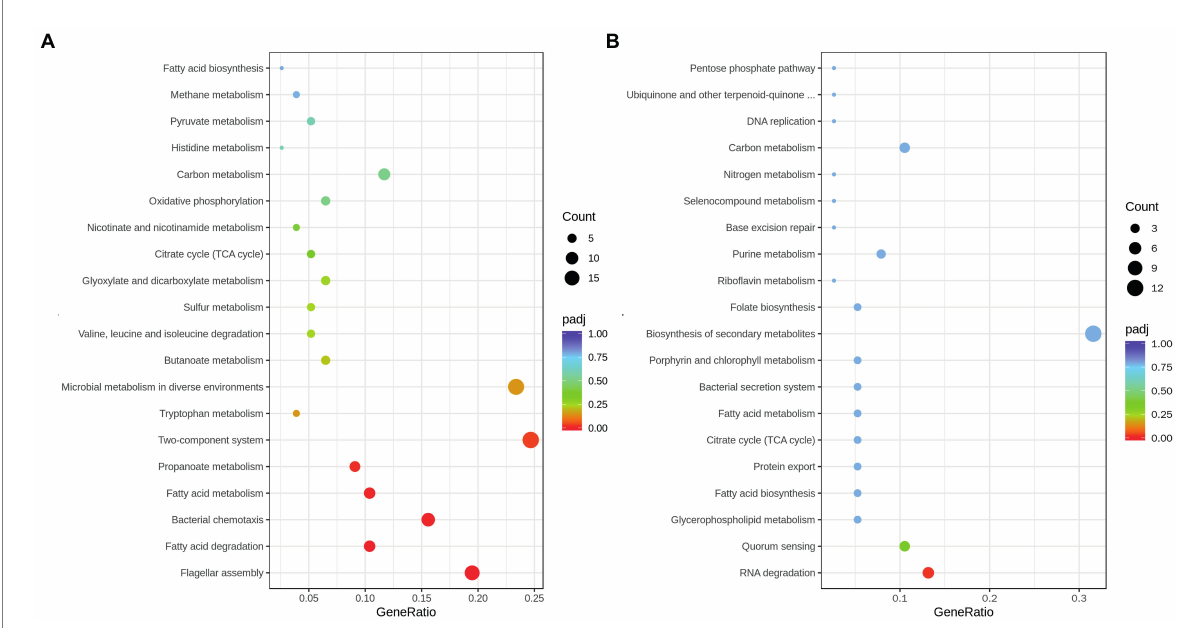
FIGURE 6 Scatterplot of upregulated genes (A) , and down-regulated genes (B) , enriched Kyoto Encyclopedia of Genes and Genomes (KEGG) pathway. Enrichment score represents the ratio of the number of upregulated/downregulated genes and the number of all genes in the